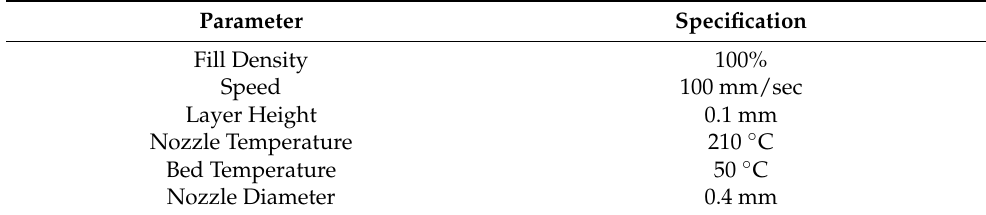
Table 4. Printing parameters of 3D printer.